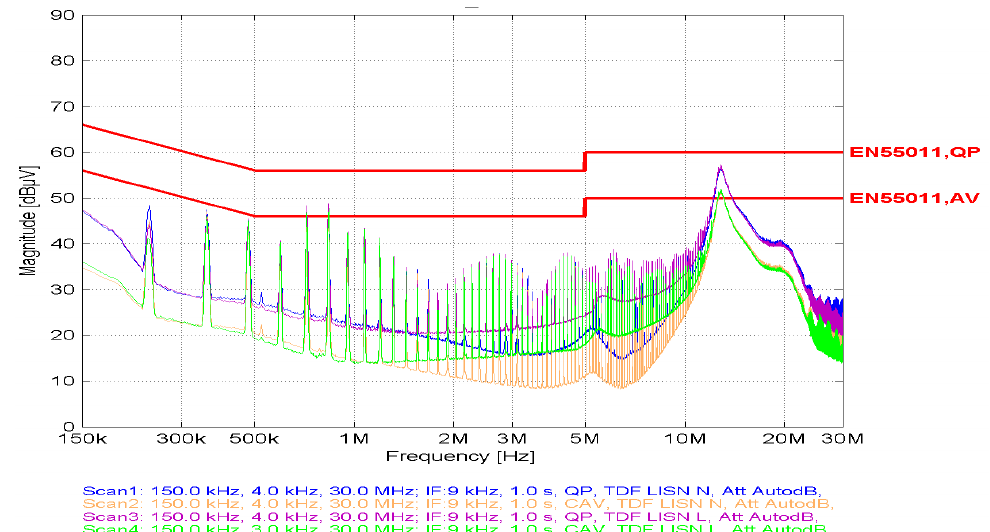
Figure 9. Attenuation level for ferrite No. 1 with the number of coils at 10 pcs.